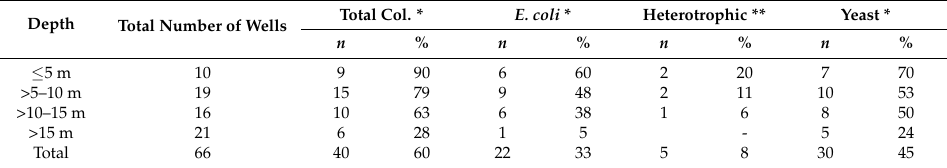
Table 3. Relationship between well depth and contamination with total coliforms, E. coli , heterotrophic bacteria, and yeast. Depth Total Number of Wells Total Col. * E. coli * Heterotrophic